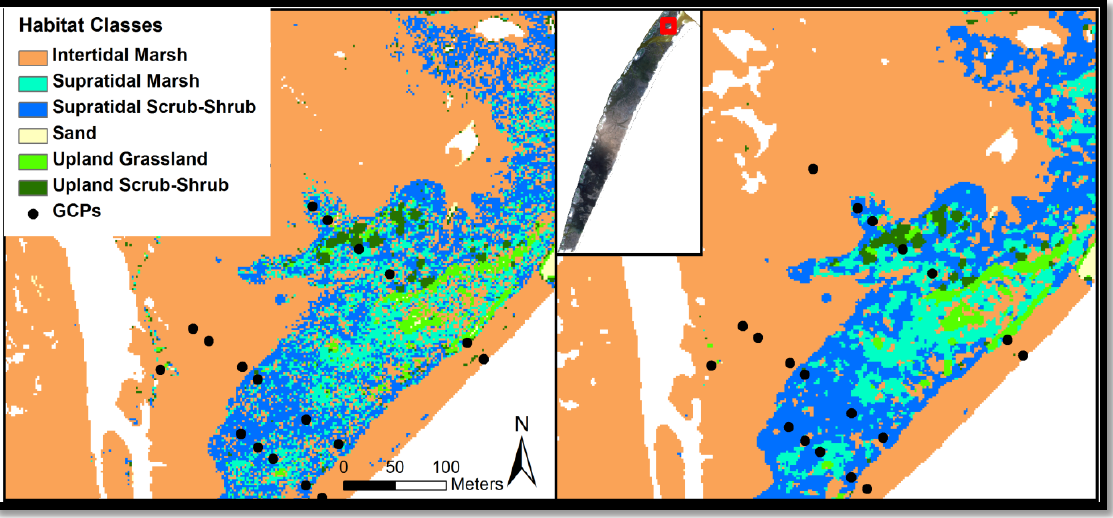
Figure 6. Non-filtered and filtered maps with a 3 × 3 majority filter for an example back barrier area. On the left is WV-2 supervised, non-filtered, non-sharpened, 8 band (66.77% accurate) and on the right is the same classification with a majority filter (72.56%